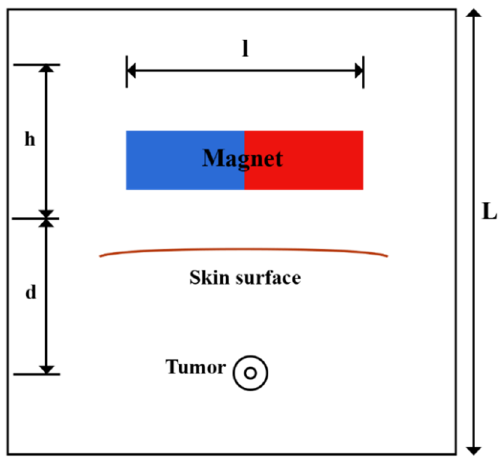
Figure 2. Schematic of the geometry of the magnetically controlled IP drug targeting model.